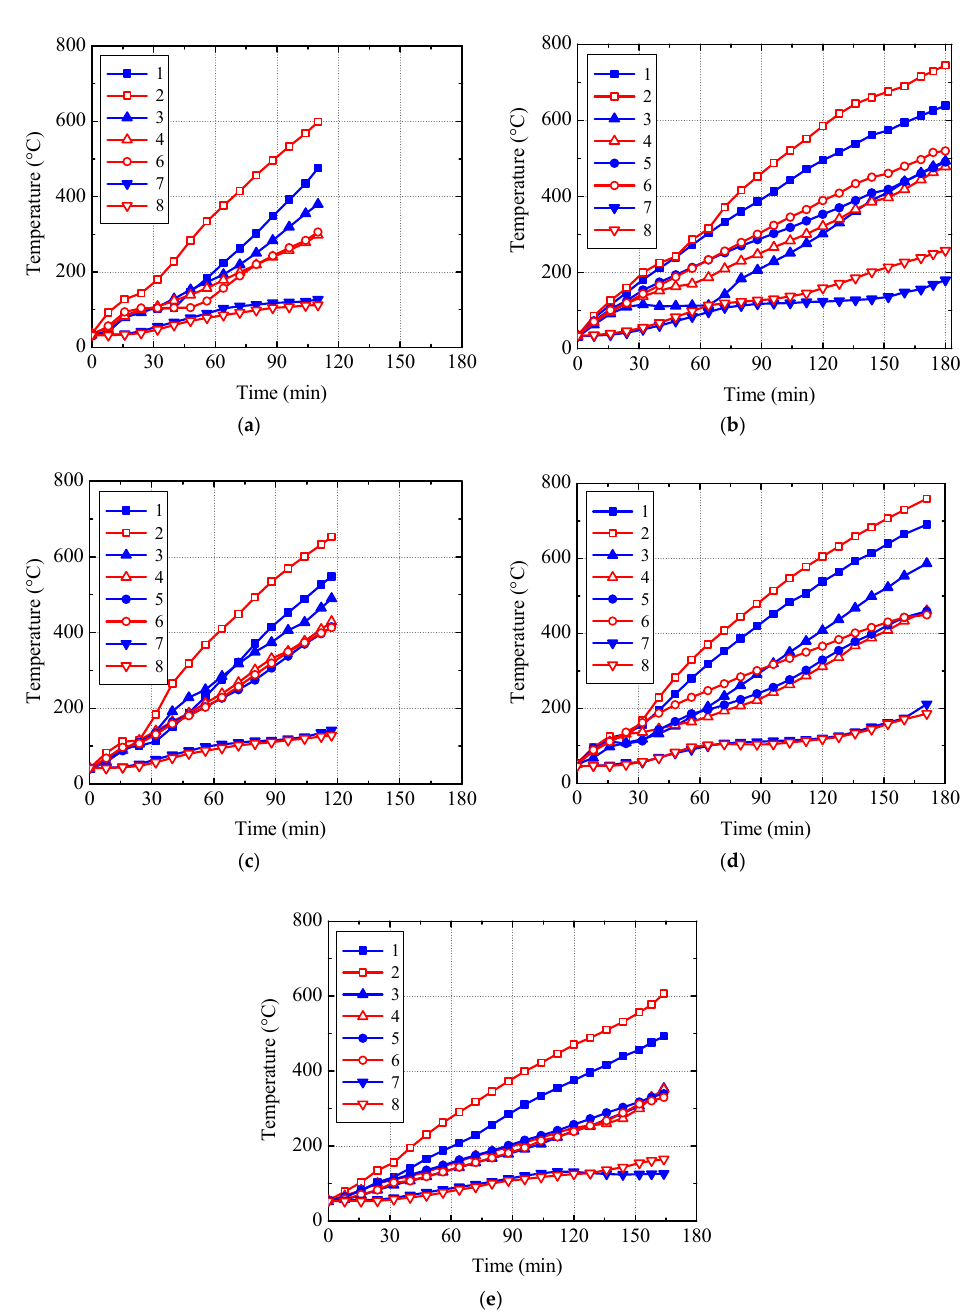
Figure 15. Measured temperature-time curves of Thermocouples 1–8: ( a ) Specimen B1, ( b ) Specimen B2, ( c ) Specimen B3, ( d ) Specimen B4, and ( e ) Specimen B5.